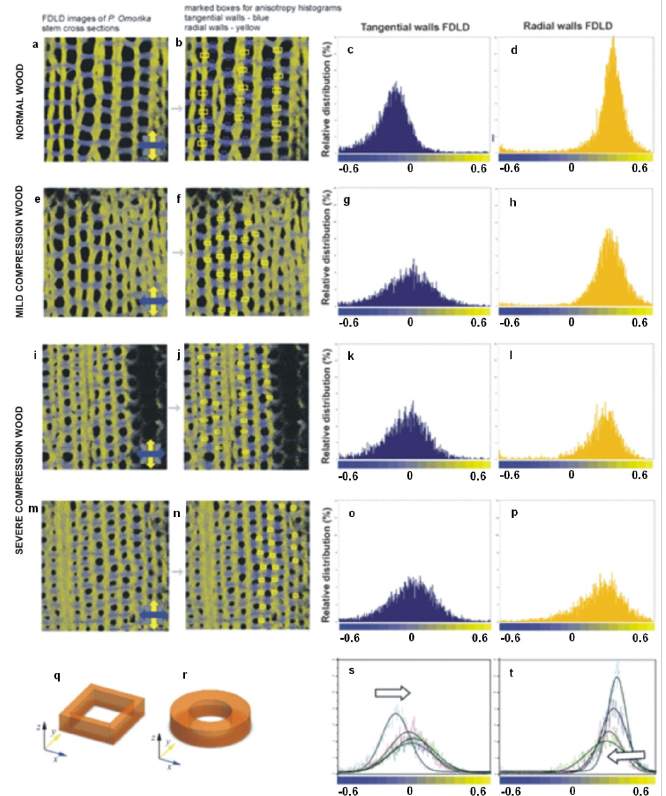
Figure 10. FDLD images of Picea omorika stem sections and corresponding anisotropy histograms. ( a ) Normal wood (NW); ( e ) mild CW; ( i , m ) severe CW; ( b , f , j , n ) pixel values were collected in the marked areas, in tangential walls (blue boxes) and in radial walls (yellow boxes), and used to obtain anisotropy distributions; ( c , g , k , o ) tangential walls FDLD distributions ( d , h , l , p ), radial walls FDLD distributions; ( s , t ) overlaid distributions with black lines representing corresponding Gaussian fits (white arrow represents gradual shifts toward grey—increasing number of disorientated fibrils); ( q , r ) schemes of NW and CW tracheids, respectively. Excitation at 488 nm, emission above 560 nm. The blue and yellow colours of the co-ordinate axes correspond to the orientation of tangential and radial walls in the images, respectively. (Published in [53], with permission from Cambridge University